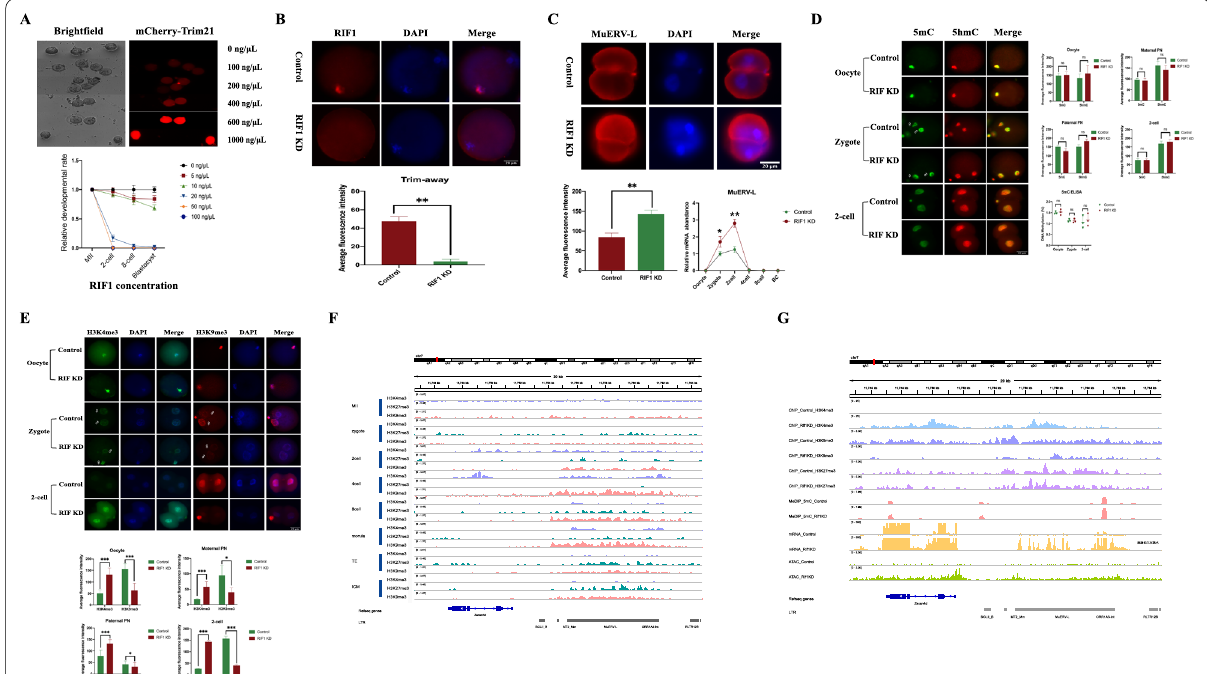
Fig. 5 RIF1 regulates MuERV-L interaction with H3K4me3 and H3k9me3. A Various concentrations of mCherry-Trim21 mRNA and RIF1 antibody were evaluated with the developmental abilities of embryos. Top: Various concentrations of mCherry-Trim21 mRNA. Bottom: Various concentrations of RIF1 antibody. B The remaining protein intensities of endogenous RIF1 were obtained between the RIF1 KD and control groups when the 10 ng/ μL RIF1 antibody was electroporated into the oocytes. Bottom: Statistical results are shown. C The expression of MuERV-L in the 2-cell embryos of the RIF1 KD and control groups. Top: Representative immunofluorescence (IF) images of 2-cell embryos. Bottom: Statistical results from IF and qPCR. D IF images of 5mC and 5hmC enrichment during ZGA between the RIF1 KD and control groups. The statistical diagrams and the ELISA results of 5mC are shown at the bottom. E IF images of H3K4me3 and H3K9me3 enrichment during ZGA between the RIF1 KD and control groups. F ChIP-seq track signals of H3K4me3, H3K9me3 and H3K27me3 from mouse oocytes to blastocysts, which were extracted from GSE73952 and GSE 98149, and visualized by Integrative Genomics Viewer (IGV). G Track signals of H3K4me3, H3K9me3, H3K27me3, 5mC, and mRNA expression at the MuERV-L-int locus in control and RIF1 KD ESCs, which were extracted from GSE98356. Throughout, n 20 in each group for IF analysis, and n 3 in each group = = for qPCR analysis. Data are presented as means SD. P values are calculated by Student’s t test. * p < 0.05, ** p < 0.01, *** p < 0.001. Scale bars are ± shown in the lower right corner of the captures. RIF1 KD: RIF1 knockdown. ♀ represents maternal pronuclear (PN). ♂ represents paternal